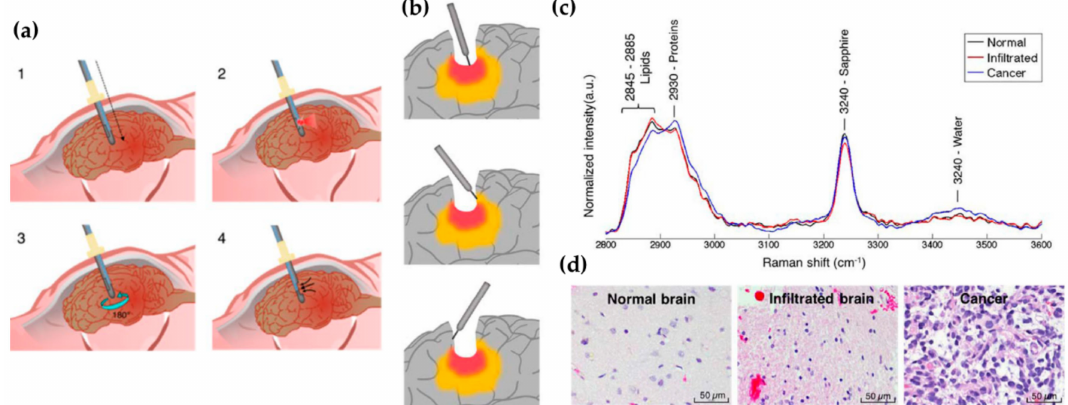
Figure 4. Schematic representation of ( a ) the acquisition steps of the Raman core needle biopsy instrument developed by Desroches et al.: (1) needle insertion, (2) Raman data acquisition, (3) 180 ◦ rotation of the needle, and (4) sample collection. ( b ) In vivo Raman measurements performed in the surgical cavity during glioma resection in dense cancer (red), infiltrated brain (yellow) and surrounding normal brain. ( c ) Normalised average Raman spectra of dense cancer, infiltrated and normal brain. ( d ) Representative H&E micrographs for each tissue type